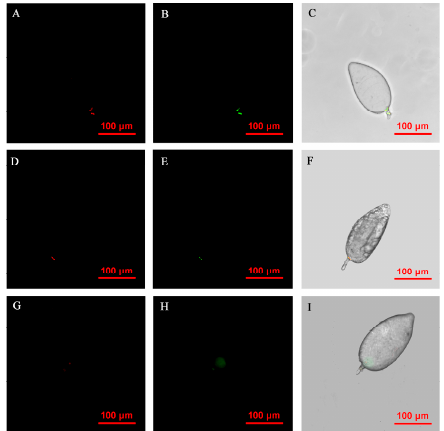
Figure 4. FISH visualization of Wolbachia and Rickettsia in egg stages (12–24 h) of B. tabaci. Localization of symbiotic bacteria Rickettsia (red) and Wolbachia (green) in the B. tabaci eggs at different times (( A – C ): 12 h, ( D – F ): 18 h, ( G – I ): 24 h). Rickettsia fluorescence ( A , D , G ) and Wolbachia fluorescence ( B , E , H ) are displayed in dark fi eld; W olbachia and Ricke tt sia fl uorescence ( C , F , I ) is displayed in bright fi eld.